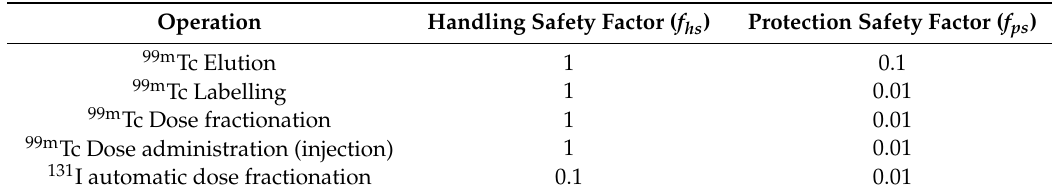
Table 5. f hs and f ps values of operations performed in the selected specialized hospital.